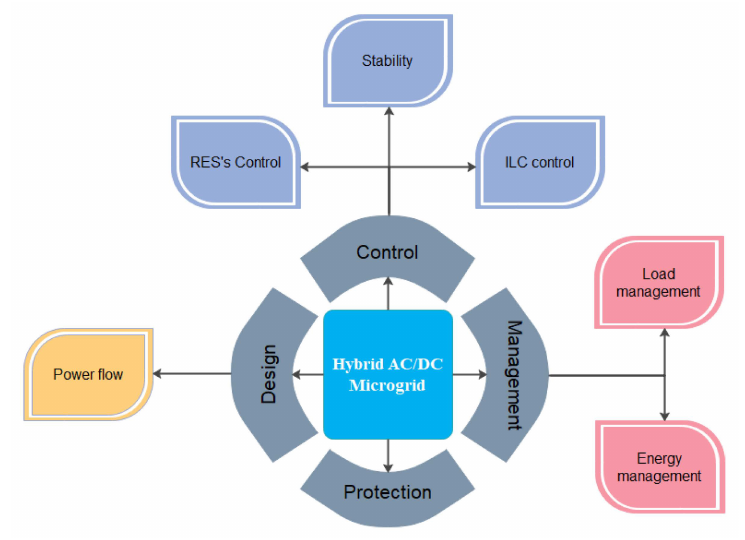
Figure 4. Issues of an operational hybrid